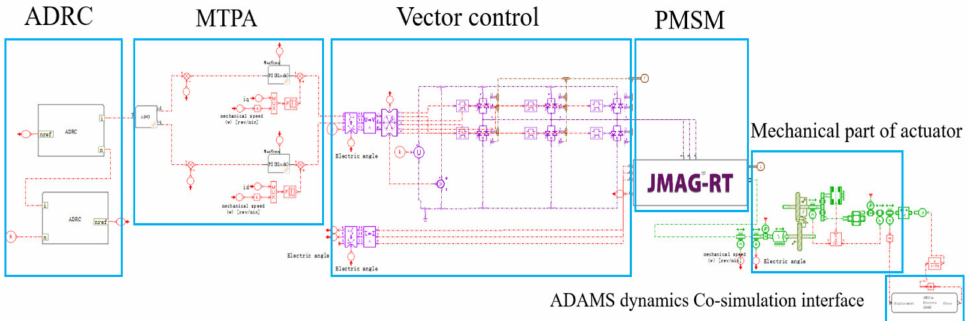
Figure 12. Overall control block diagram of